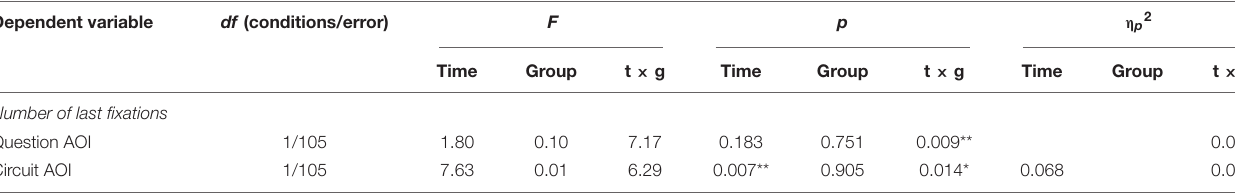
TABLE 3 | Results of mixed ANOVAs for the dependent measures of gaze behavior, separated for the effects for the factors time, group and the interaction between time and group (t × g). Dependent variable df (conditions/error)